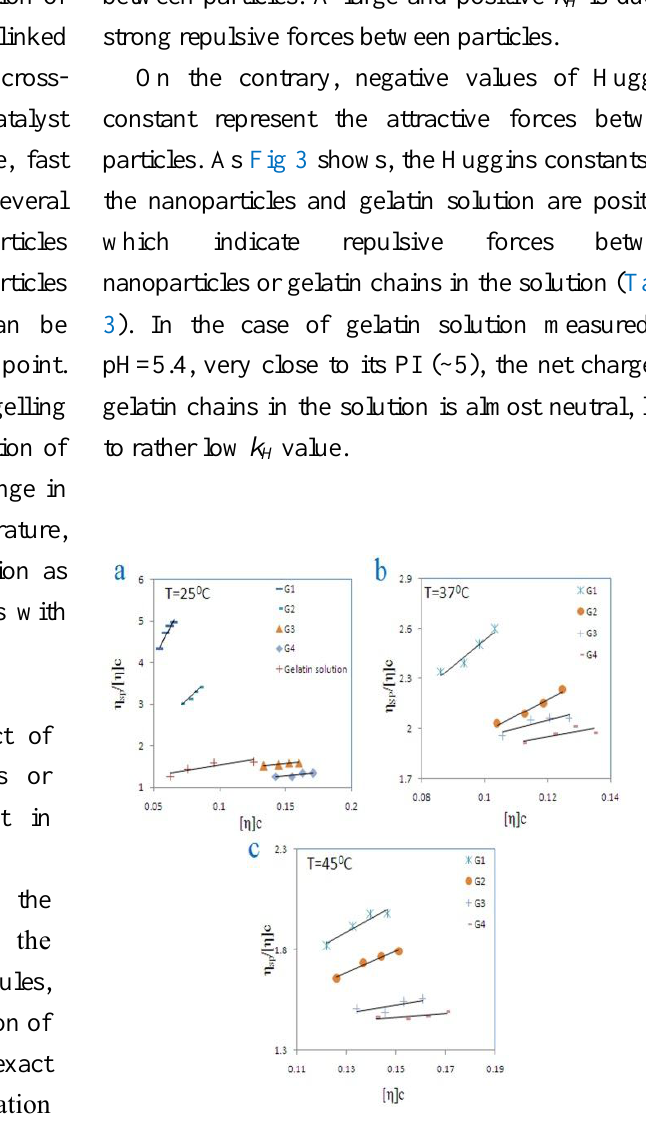
Fig. 3. Huggins function vs. reduced concentration for gelatin nanoparticles at different temperatures, 25 0 C (a), 37 0 C (b) and 45 0 C